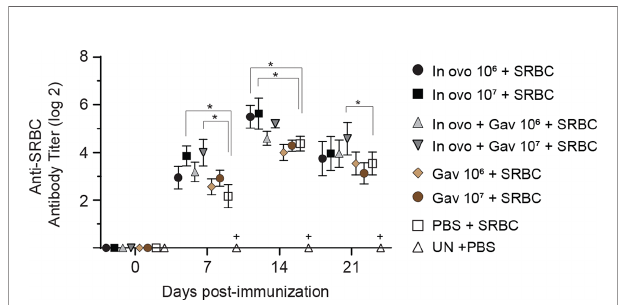
FIGURE 7 | Serum anti-SRBC antibody titers as determined by direct hemagglutination assay. Serum samples were collected post-hatch from chickens immunized with SRBC and pre-treated with a lactobacilli cocktail as follow: groups 1 and 2 received 10 6 and 10 7 CFUs of lactobacilli cocktail in ovo , respectively, at embryonic day eighteen; groups 3 and 4 received 10 6 and 10 7 CFUs of lactobacilli, respectively, via both in ovo and oral gavage (on days 1, 7, 14, 21, 28 post-hatch); groups 5 and 6 received 10 6 and 10 7 CFUs of lactobacilli, respectively, via oral gavage; group 7 was injected with phosphate-buffered saline (PBS); group 8 remained untreated (UN). On days 14 and 21 post-hatch, birds were immunized intramuscularly with 2% SRBC in 0.25 ml of ml PBS. The untreated group (UN) was inoculated intramuscularly with 0.5 ml of PBS and served as the negative control. Statistical signi fi cance among treatment groups was calculated using SAS Proc GLM (General Linear Model) followed by Tukey ’ s comparison test. Error bars represent standard errors of the mean. Results were considered statistically signi fi cant if P < 0.05. Bars with asterisks represent a signi fi cant difference among treatments. The data are representative samples from 12 individual birds.